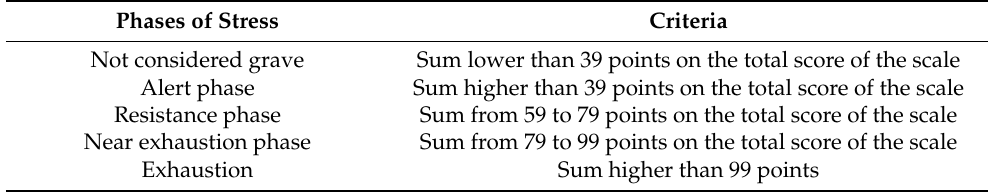
Table 2. Criteria to determine the phases of the Infantile Stress Scale. Phases of Stress Criteria Not considered grave Sum lower than 39 points on the total score of the scale Alert phase Sum higher than 39 points on the total score of the scale Resistance phase Sum from 59 to 79 points on the total score of the scale Near exhaustion phase Sum from 79 to 99 points on the total score of the scale Exhaustion Sum higher than 99